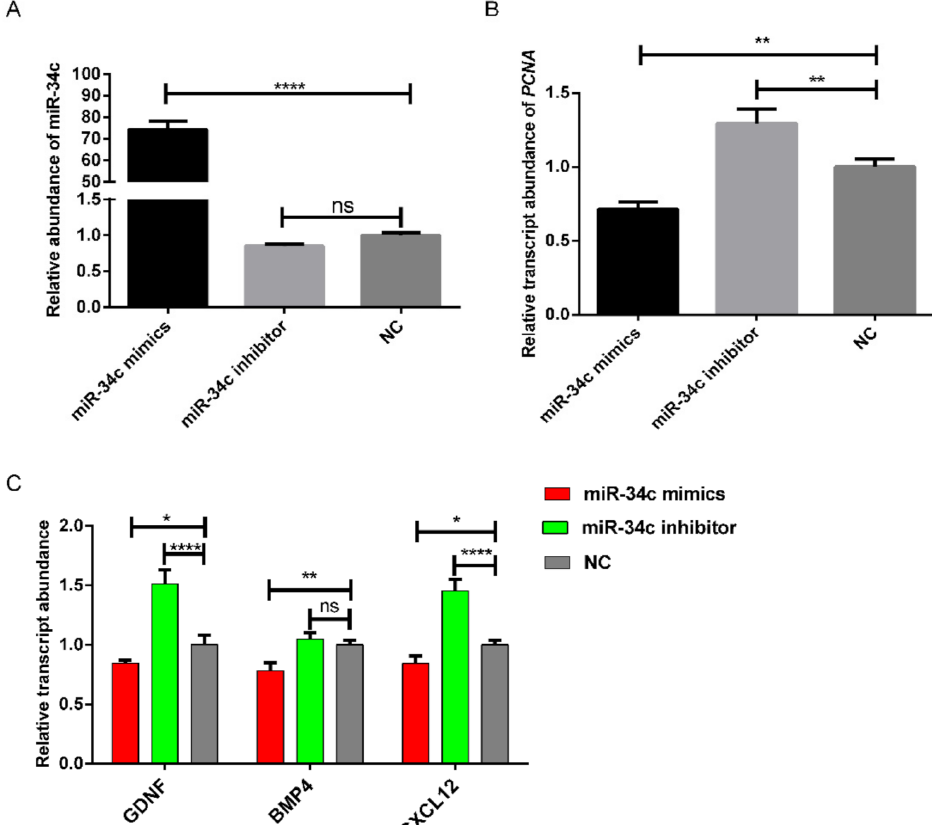
Figure 1. MiR-34c inhibits the proliferation-related gene expression in bovine Sertoli cells. ( A ) MiR- 34c was upregulated in Sertoli cells after transfection with miR-34c mimics, and miR-34c was downregulated in Sertoli cells after transfection with the miR-34c inhibitor for 48 h. U6 was used as a reference. ( B ) Detection of the relative expression level of PCNA after transfection with miR-34c mimics, miR-34c inhibitor or Negative Control for 48 h. β -actin was used as a reference gene. ( C ) After transfection for 48 h, qRT-PCR was used to detect the relative abundance of the transcript of GDNF , BMP4 and CXCL12 in bovine Sertoli cells, and β -actin was used as a reference gene. * p < 0.05; ** p < 0.01; **** p